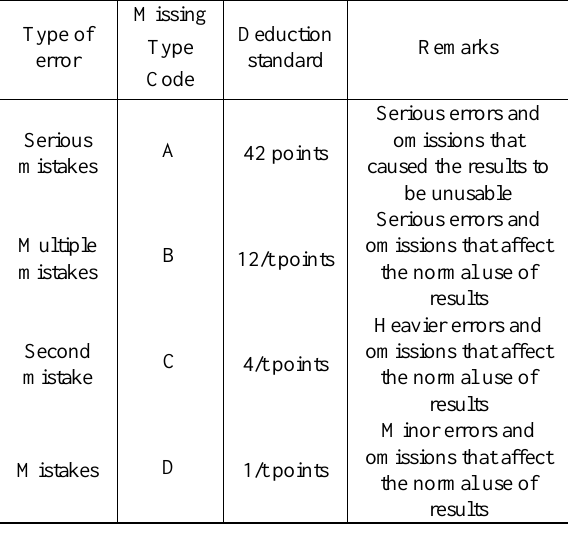
Table 9 . Quality judgment conditions of batch